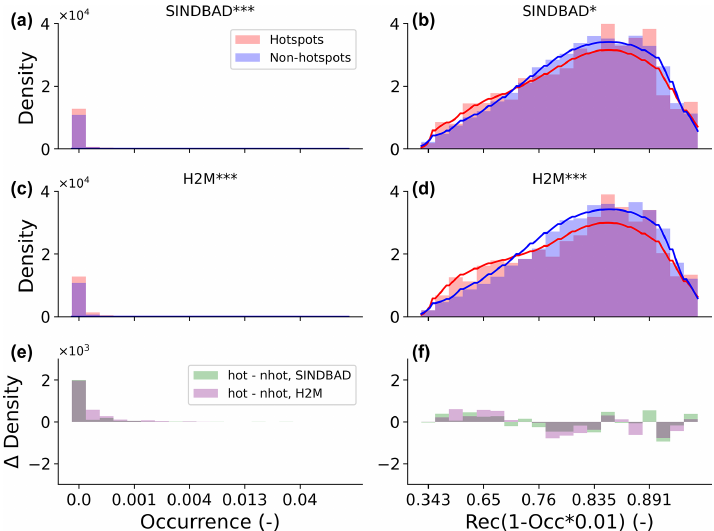
Figure B14. Same as Fig. 7 but using the occurrence (a, c, e) and the product of the recurrence and occurrence (b, d, f) of the surface